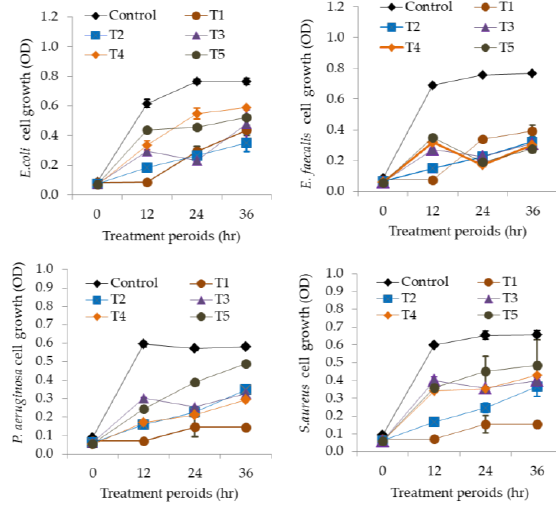
Figure 2. antibacterial activities of lyophilized ECS of KCC-52 at the different concentrations and incubation periods. Data are expressed as the mean ± S. E.M. of five replicates. The analysis was performed with three technical replicates from each sample. T1—20 mg / mL, T2—10 mg / mL, T3—5 mg / mL, T4—2.5 mg / mL and T5—1.25 mg / mL of lyophilized